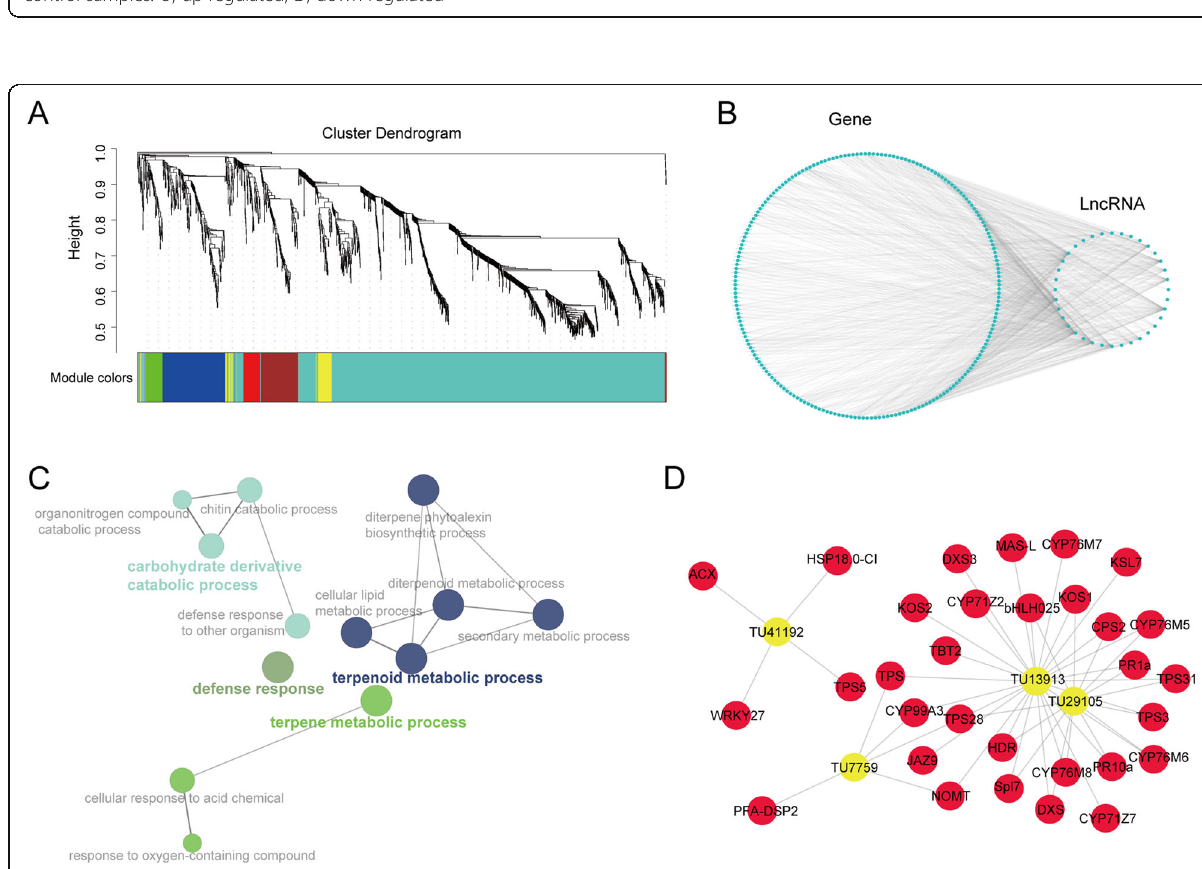
Fig. 4 Co-expression analysis blast fungus-responsive genes and LncRNAs and GO enrichments of genes associated with LncRNAs. a Weighted correlation network analysis (WGCNA) of deferentially expressed (DE) LncRNAs and mRNAs. For DE-genes, we used the cutoff: foldchange > 2, Adjust p value < 0.05. Colors represent modules generated by WGCNA. b Network of module turquoise on the basis of WGCNA analysis. We used the cutoff: weight > 0.4. c Gene Ontology (GO) enrichment analysis of genes selected in ( b ). The size of character represents the significance of the GO; Color of the bubble represents GO group. d Network plot of correlation between four DE-LncRNAs and known pathogen resistance- related genes. The information of these blast pathogen resistance-related genes were listed in Table